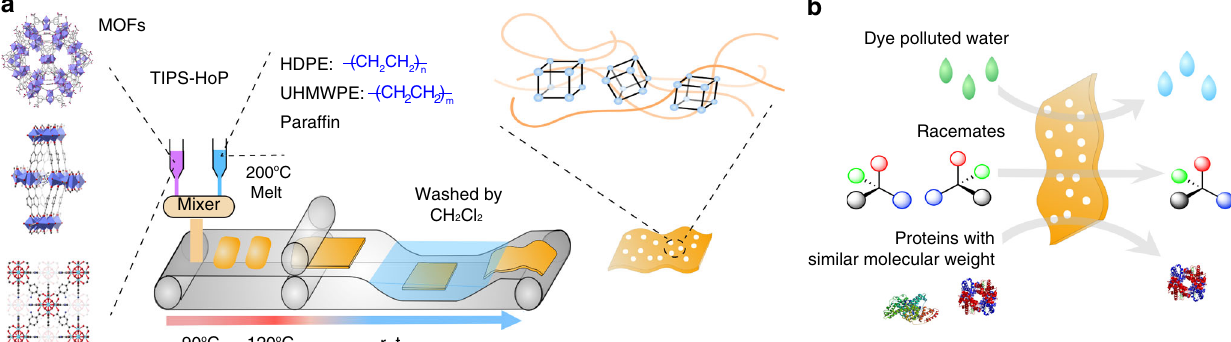
Fig. 1 MOF PE MMMs prepared by TIPS-HoP. a Schematic of the MOF PE MMMs fabrication process using the TIPS-HoP method. b Schematic illustration of the MOF PE MMMs for dye, racemates, and protein